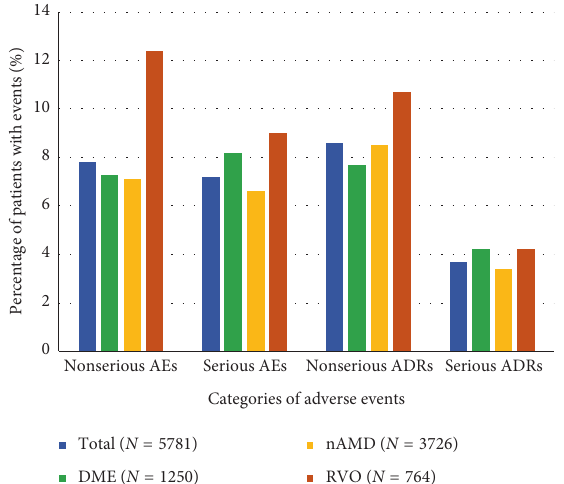
Figure 1: Incidence rates for adverse events by category across indications (nAMD, DME, and RVO). Nonserious AEs and ADRs occurred more frequently among RVO patients compared to nAMD and DME patients. Serious AEs and ADRs occurred slightly less frequently in nAMD patients than in RVO and DME. AE, adverse event; ADR, adverse drug reaction; DME, diabetic macular edema; nAMD, neovascular age-related macular degeneration; RVO, retinal vein occlusion.